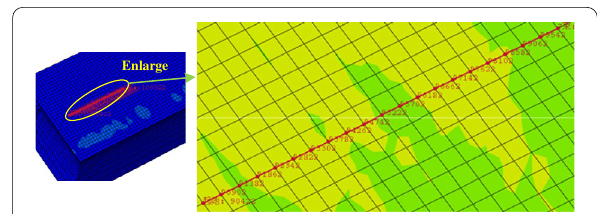
Figure 8 Coordinate extraction figure